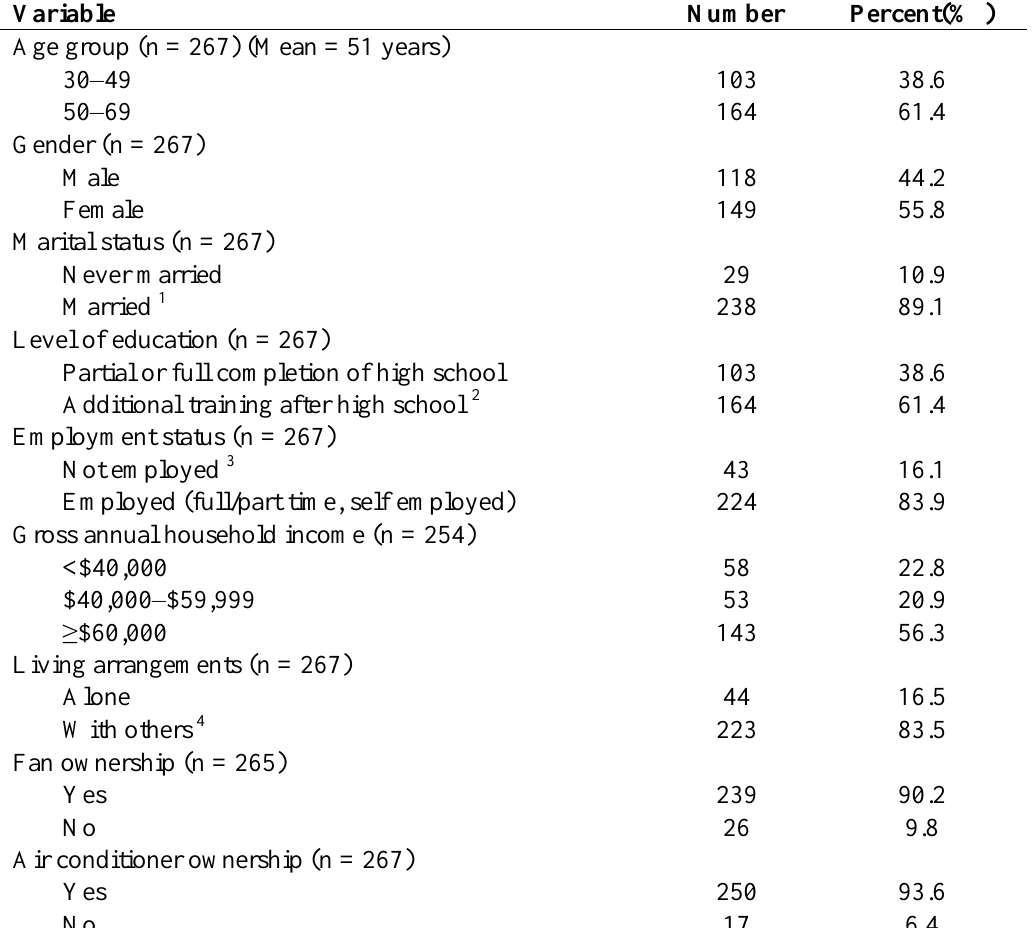
Table 2. Demographic and household characteristics of the study